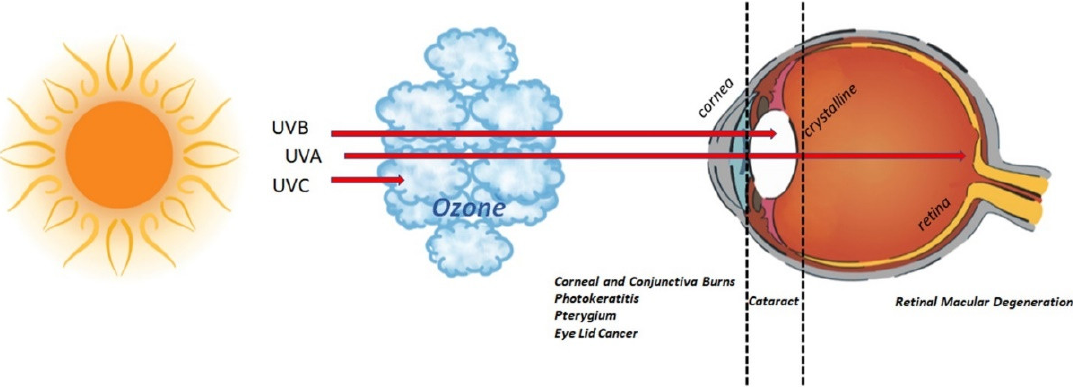
Figure 5. UV radiation and eye. Schematic representation of UV route inside the eye. Sunlight is a natural source of UV, accountable for 10% of UV rays (including UV-B, 290 to 320 nm) [32]. As depicted in the graphical representation, UV-C (280 nm) are absorbed by the ozone in the atmosphere; UV-B rays (280 – 315 nm) are completely absorbed by corneal structure and crystalline; UV-A rays (315 – 400 nm) are partially absorbed by the cornea, while the remainder can reach the retina. Exposure to UV rays might insult the visual system or lead to/exacerbate an existing chronic status (pterygium, cataract, retinal macular degeneration). The major eye disorders associated with UV ray exposure are listed below the eyeball.